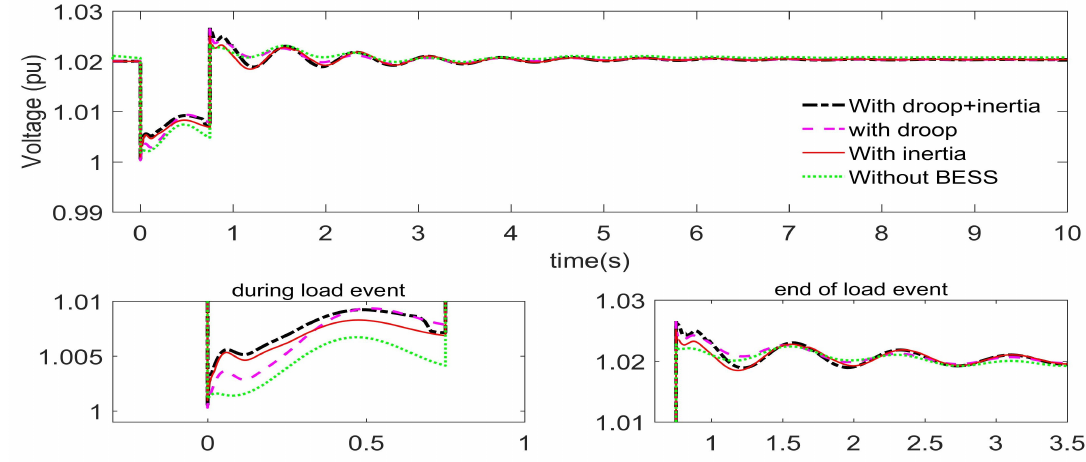
Figure 8. The voltage (pu) at the point of common coupling (PCC) with the load event.